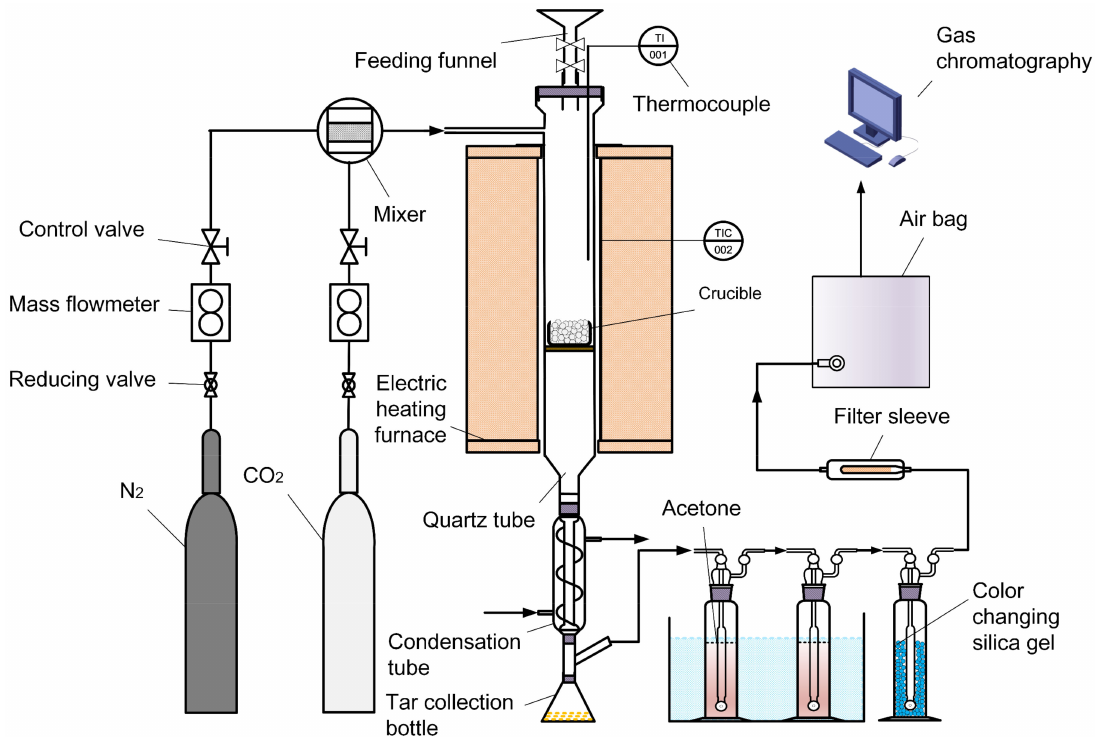
Figure 7. Flow chart of gasification